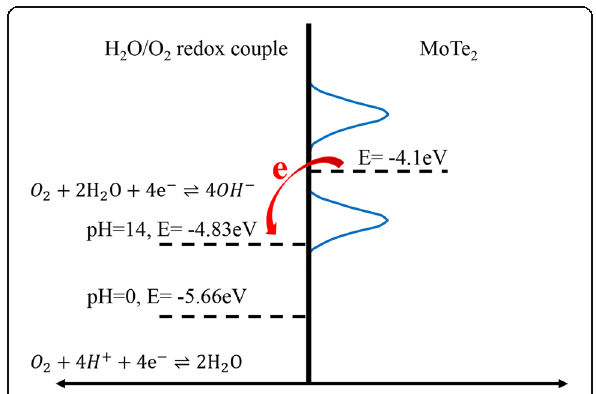
Fig. 8 Energy diagram of the water/oxygen redox couple (left) and MoTe 2 (right); the red arrow indicates the electron transfer